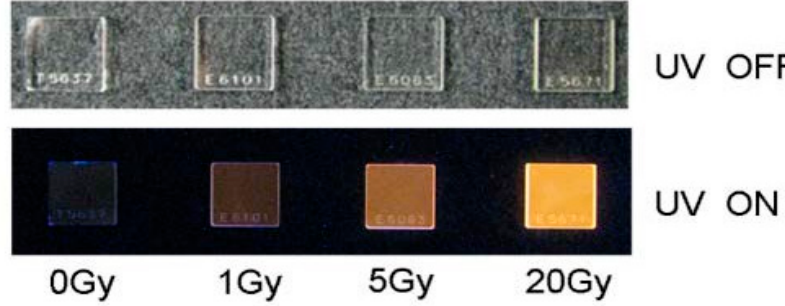
Figure 2. RPL emission image of Ag + -doped phosphate glass as a function of X-ray absorbed dose. The upper shows UV excitation off and lower UV excitation